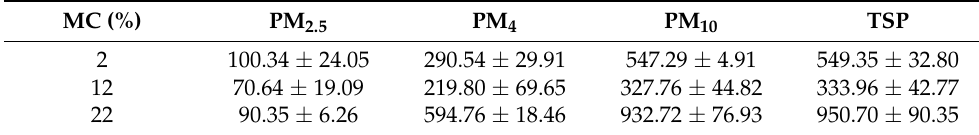
Table 2. The EF of PM from the smouldering combustion (g/kg).